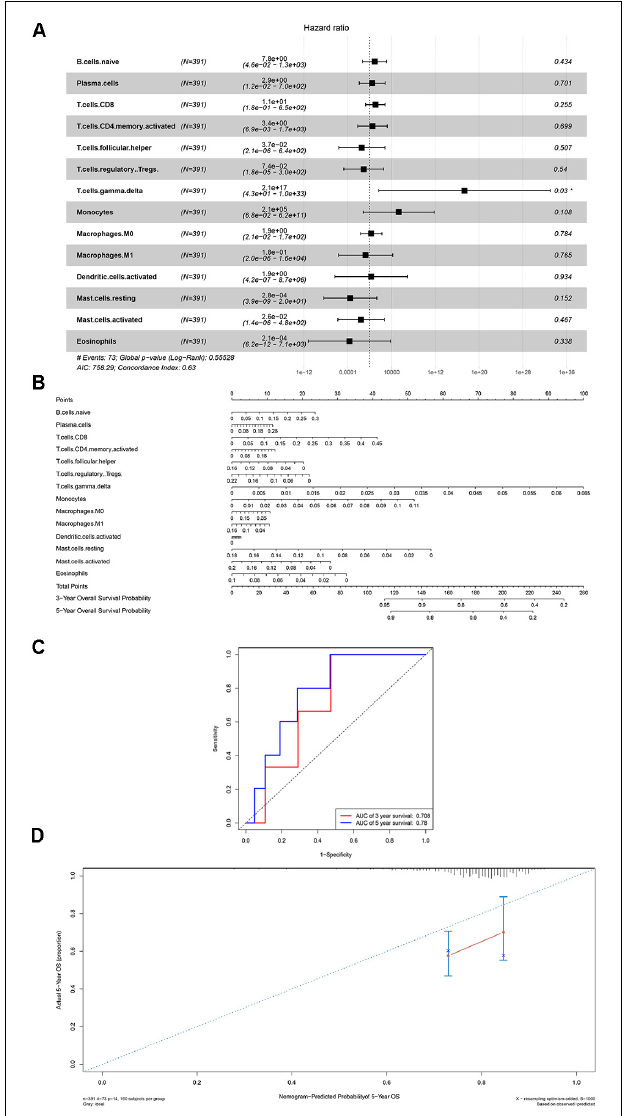
FIGURE 6 | The results of the multivariate Cox regression (A) , nomogram (B) and model diagnosis process ROC and calibration curves (C,D) on account of the significant immune cells which were associated with survival. * P <